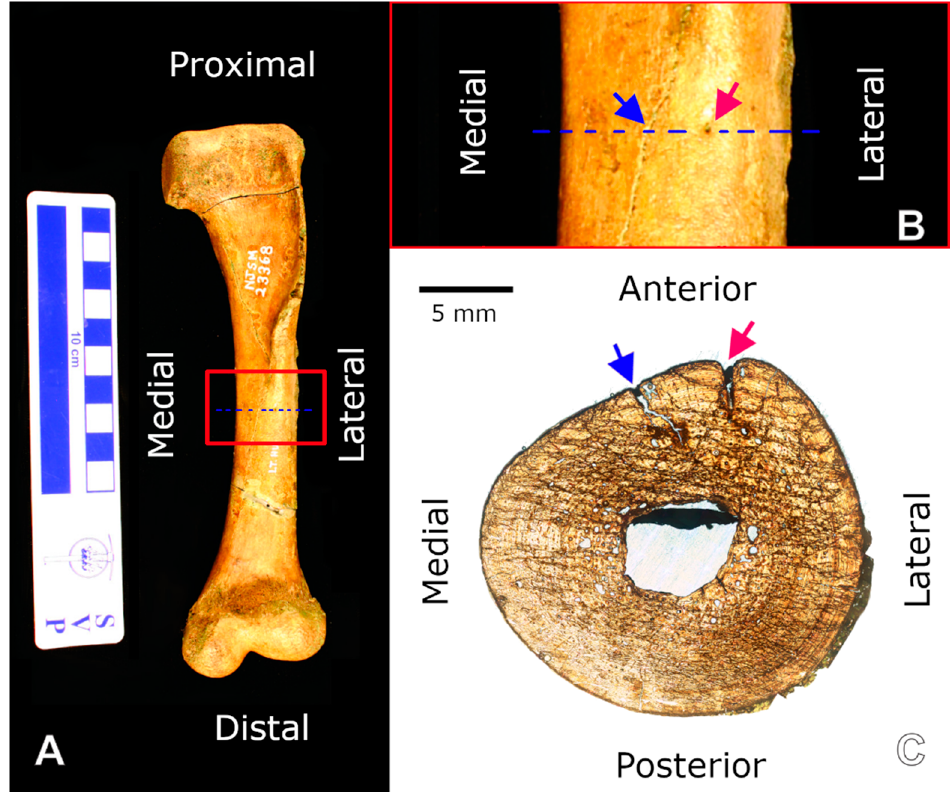
Figure 3. Left humerus of NJSM 23368; ( A ) anterior view. Scale bar is 10 cm; ( B ) A crack (blue arrow) and nutrient foramen (red arrow) are clearly visible in this close-up image of the midshaft (red square in ( A )). The dotted line indicates the exact location of the thin section pictured in ( C ); ( C ) Slide 2 transverse thin section of the midshaft. Because both the crack and the foramen are located along the top of the section image, it clearly corresponds to the anterior half of the cross-section. The remaining thin sections of all elements in the study were oriented to their respective bone elements similarly through the use of landmarks such as cracks and comparison of the shape of the perimeter of the section to the external morphology of the sampled shaft. Scale bar is 5 mm. A close-up of the nutrient foramen under circularly polarized light (CPL) can be seen in Figure 6E.